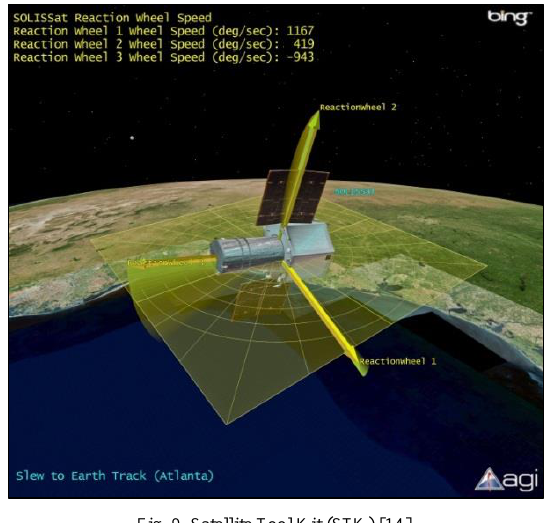
Fig. 9. Satellite Tool Kit (STK) [14].